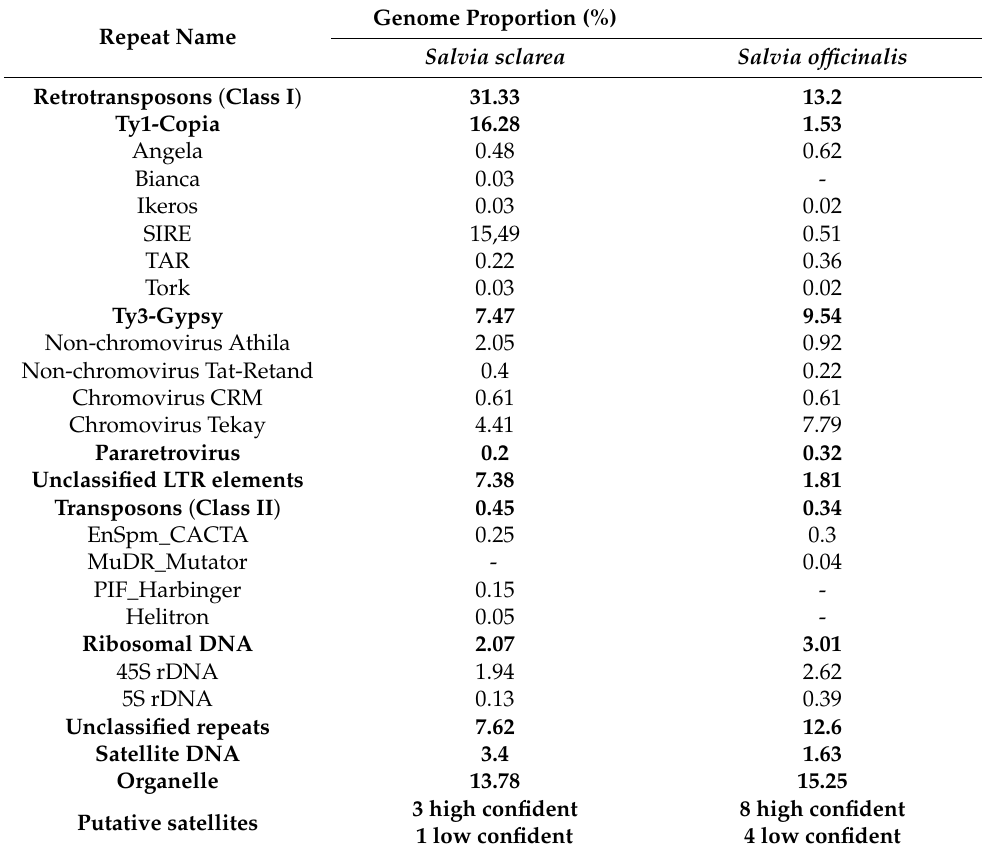
Table 1. Proportion of major repetitive DNA sequences identified in genomes of S. officinalis and S. sclarea